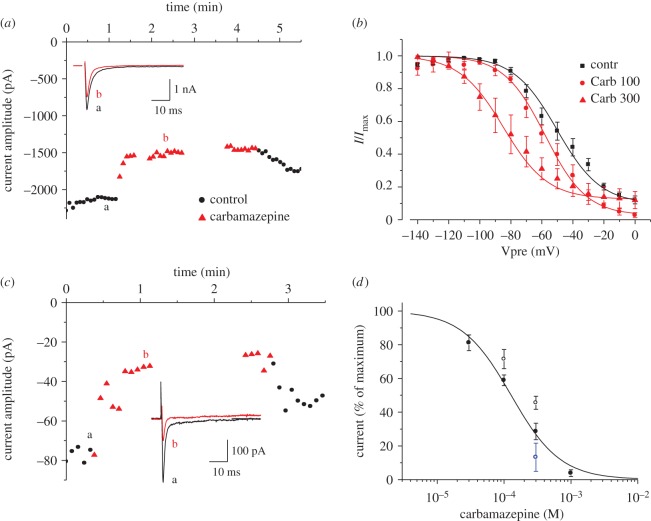
Carbamazepine inhibits Nav1.7 channels. (a,c) Nav1.7 current was measured from a holding potential of −80 mV in HEK 293 cells (a) or −120 mV in islet cells (c). Carbamazepine 100 (a) or 300 μM (c) inhibited the current reversibly. Insets show Na+ currents in the absence and presence of drug taken as indicated by the letters (a,b). (b) Steady-state inhibition of Nav1.7 in HEK 293 cells. The half-maximal inactivation was determined as V0.5 and was −50.2±3.8 for control and −57.8±3.8 and −84.7±7.5 for 100 and 300 μM carbamazepine, respectively. (d) Dose–response curves. In HEK 293 cells, cumulative inhibition was measured. The results from five to six cells per concentration were averaged and the curve calculated by a Hill equation (solid line). Similar results were obtained in isolated islet cells at HP −120 mV (open circles) or HP −80 mV (open blue circle).